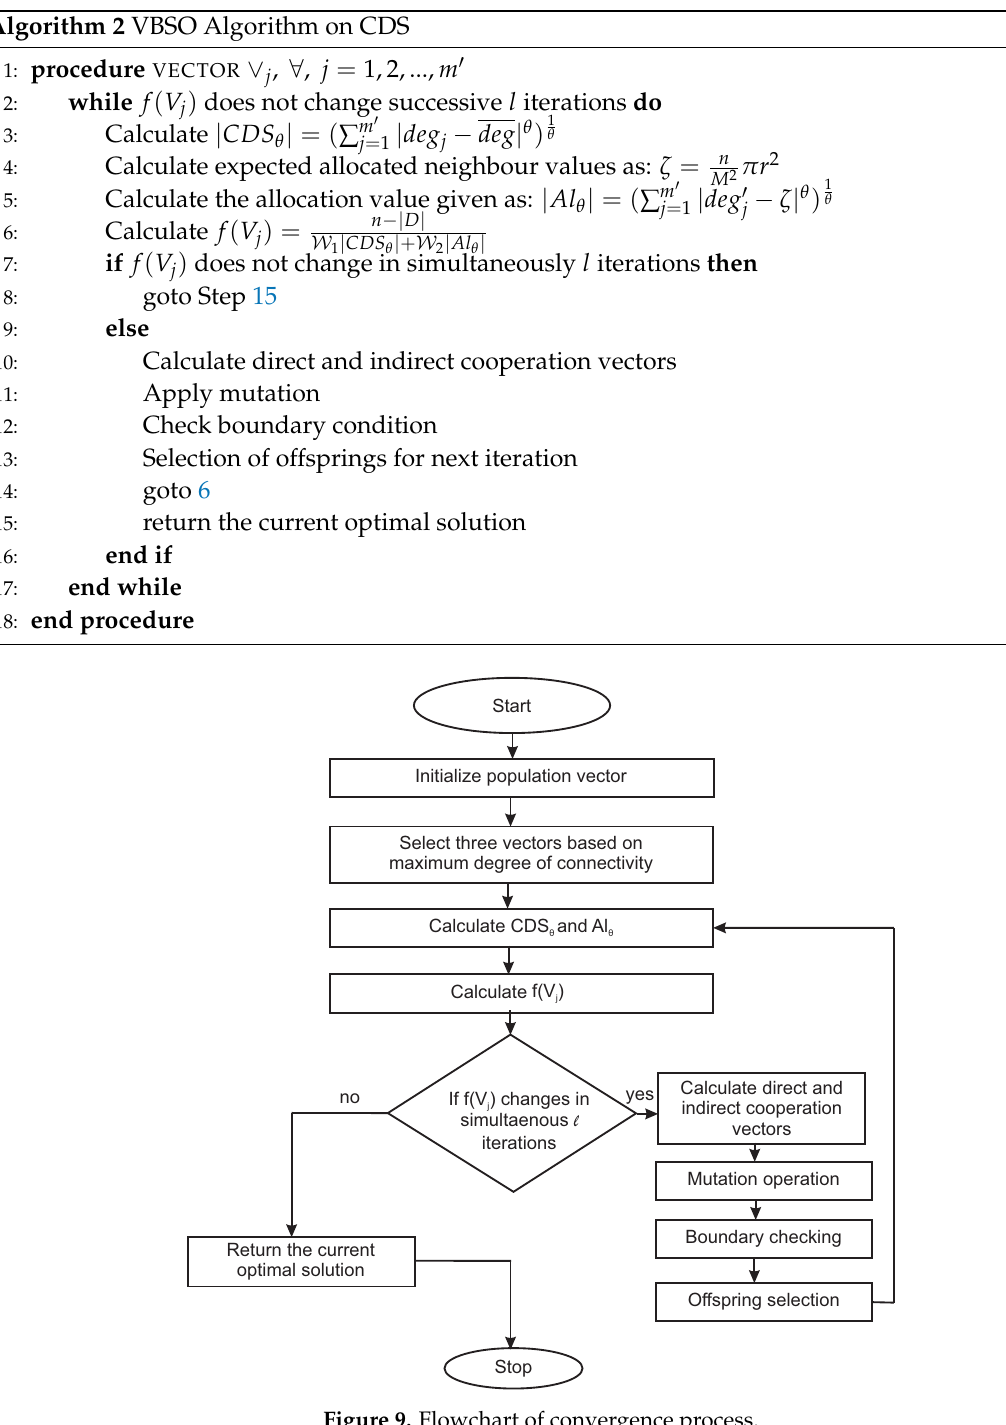
Figure 9. Flowchart of convergence